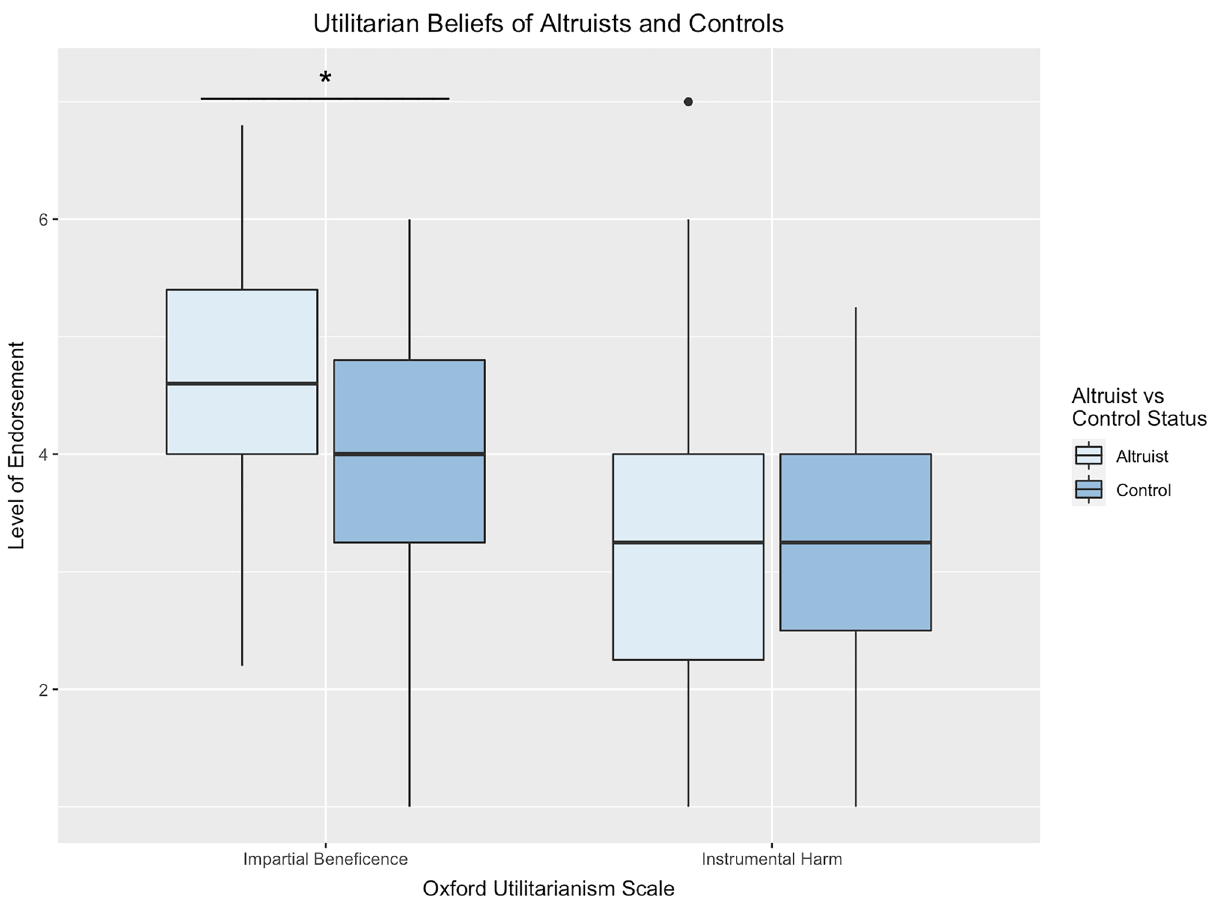
Figure 2. Boxplot of Oxford utilitarianism subscales for altruists and demographically matched controls. Note. + P < .1; * P < .05; ** P < .01; *** P < .001.